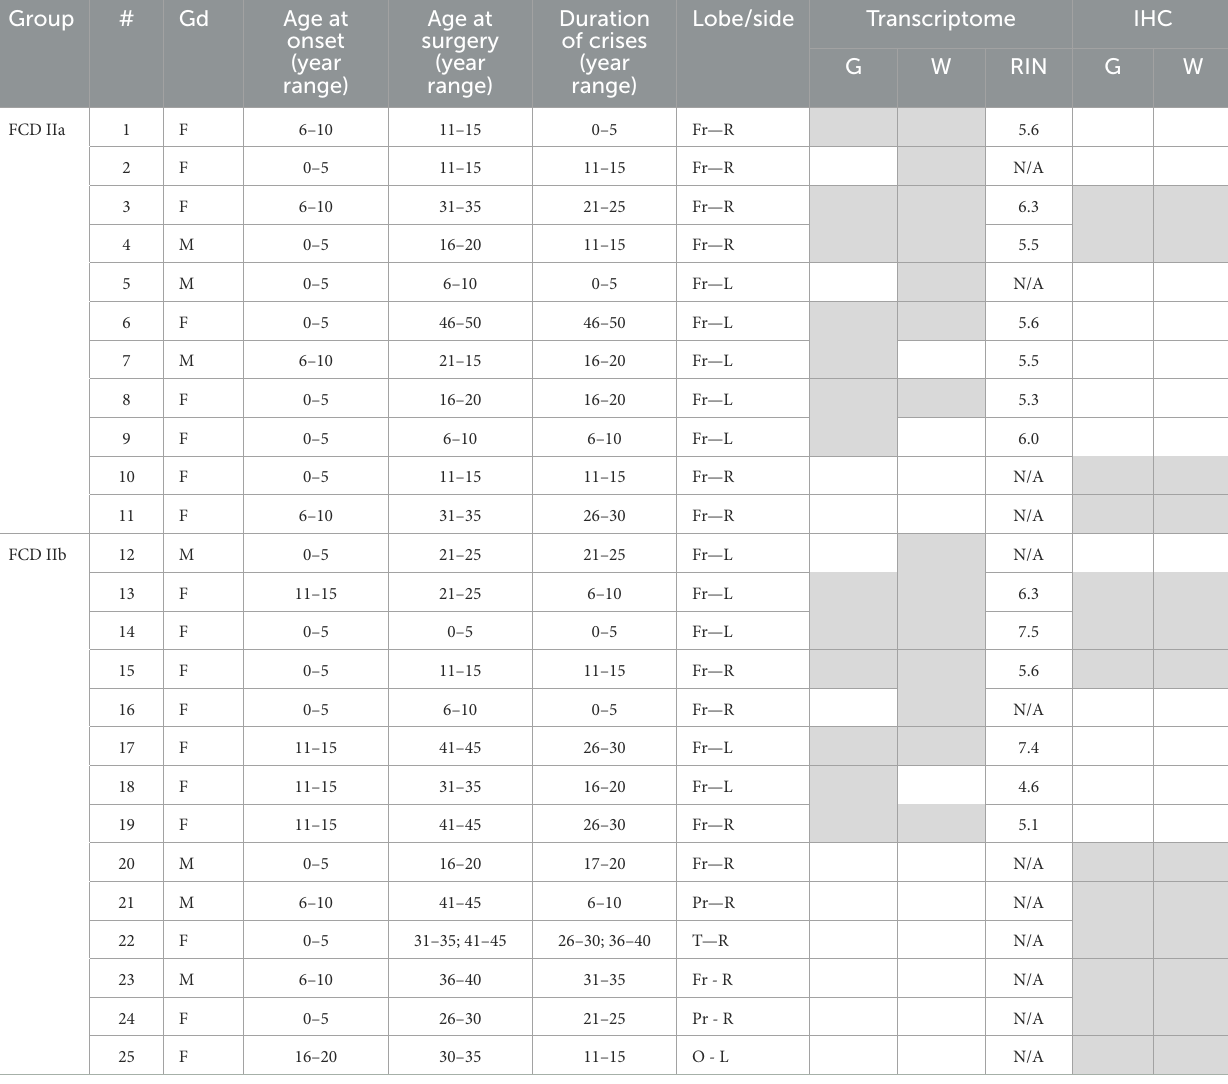
TABLE 1 Clinical data of the individuals with diagnosis of FCD ILAE Type II, whose surgical samples were submitted for transcriptome analysis and/or immunohistochemical validation.